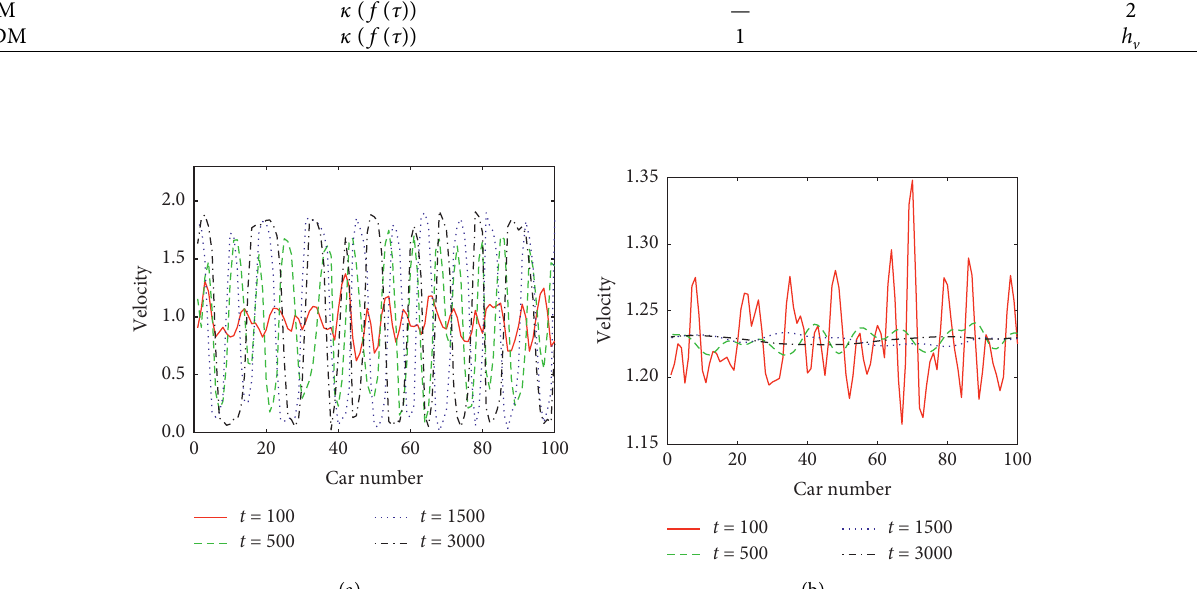
Figure 7: Profiles of velocities at time step t � 100, 500, 1500, and 3000 when κ obeys log-normal distribution. (a) OVM. (b) DSDM.